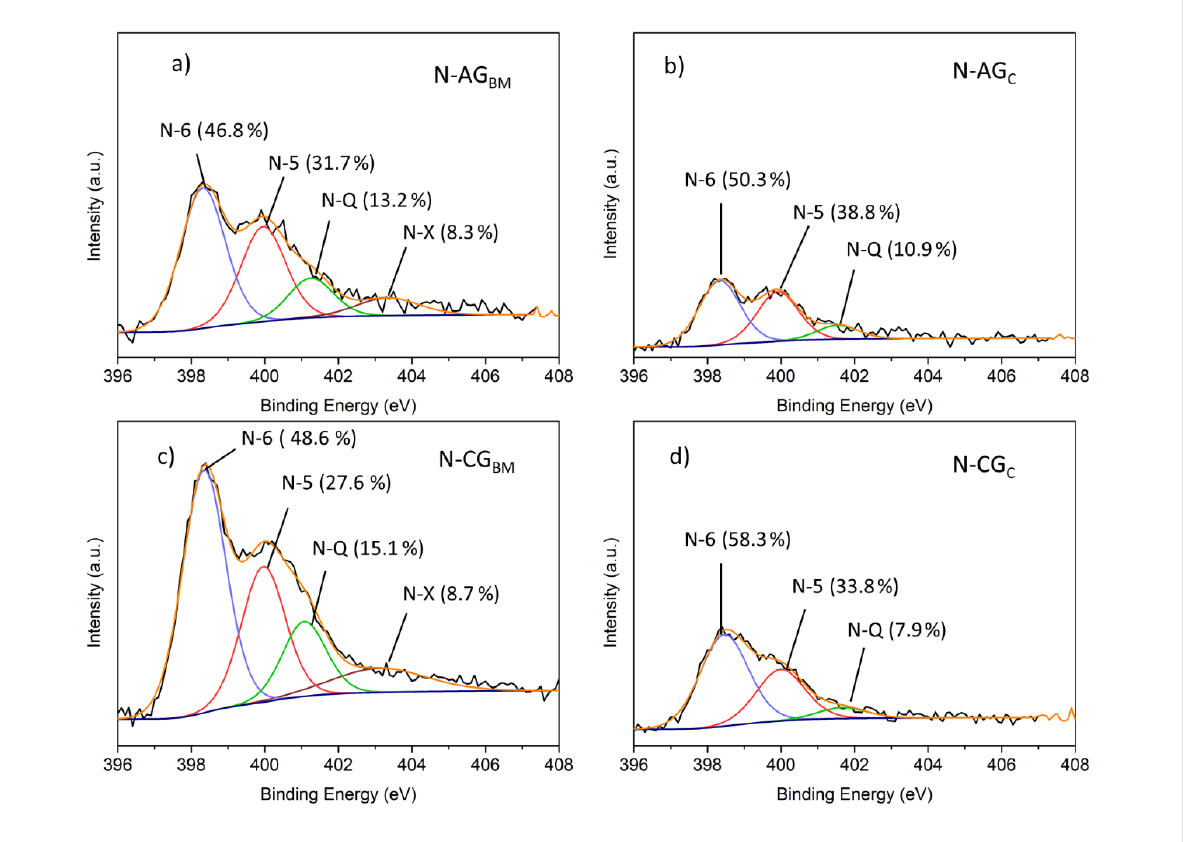
Figure 4: Deconvolution of the XPS N 1s spectra for N-AG BM (a) N-AG C (b), N-CG BM (c) and N-CG C